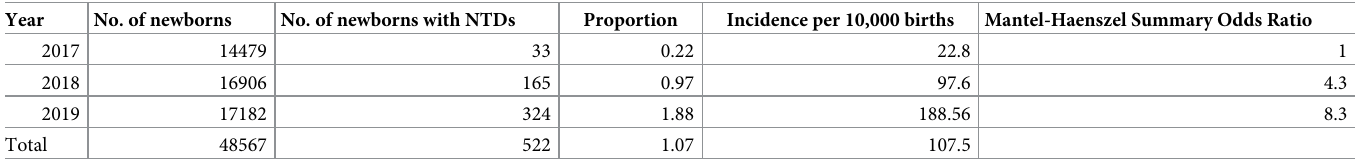
The proportion of mothers who did not receive iron and folate supplementation and had at least one of the NTDs ranged from 68.0 percent to 88.4%. Similarly, the percentage of mothers Table 5. Linear trend of NTDs incidence Eastern Ethiopia, data from September 2017–2019. No. of newborns with NTDs Incidence per 10,000 births Mantel-Haenszel Summary Odds